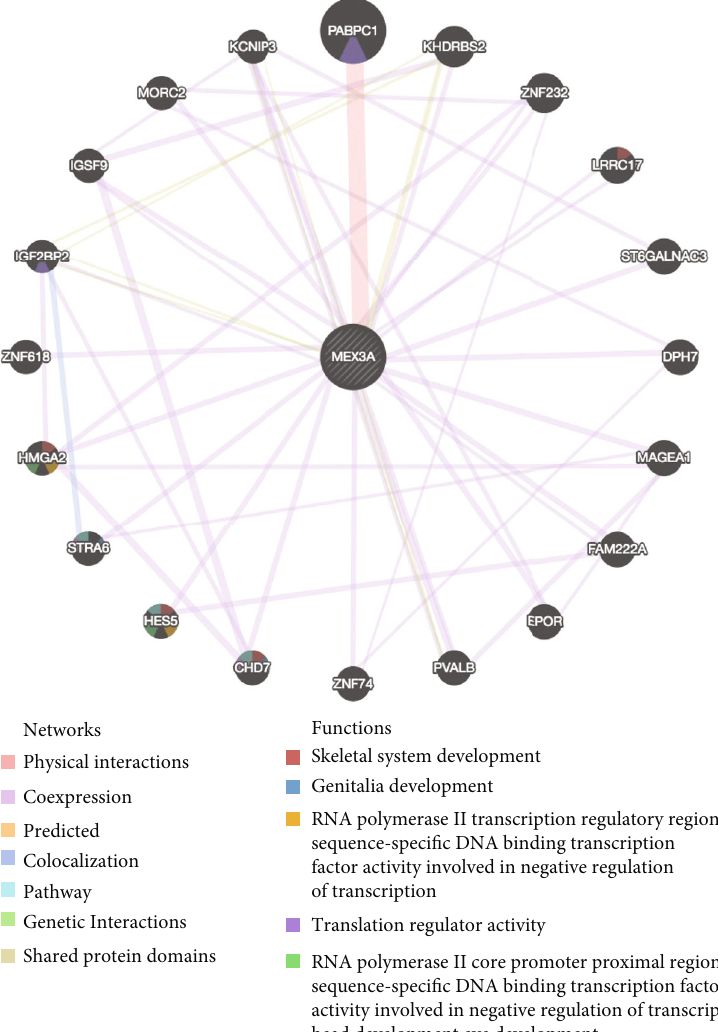
Figure 3: Gene-gene interaction network between MEX3A and correlated genes (GeneMANIA). Each node represents a gene. The node size indicates the strength of the interaction. The connecting lines between nodes represent the type of gene-gene interaction, and the line color represents the type of interaction. Node colors represent the possible biological functions of each